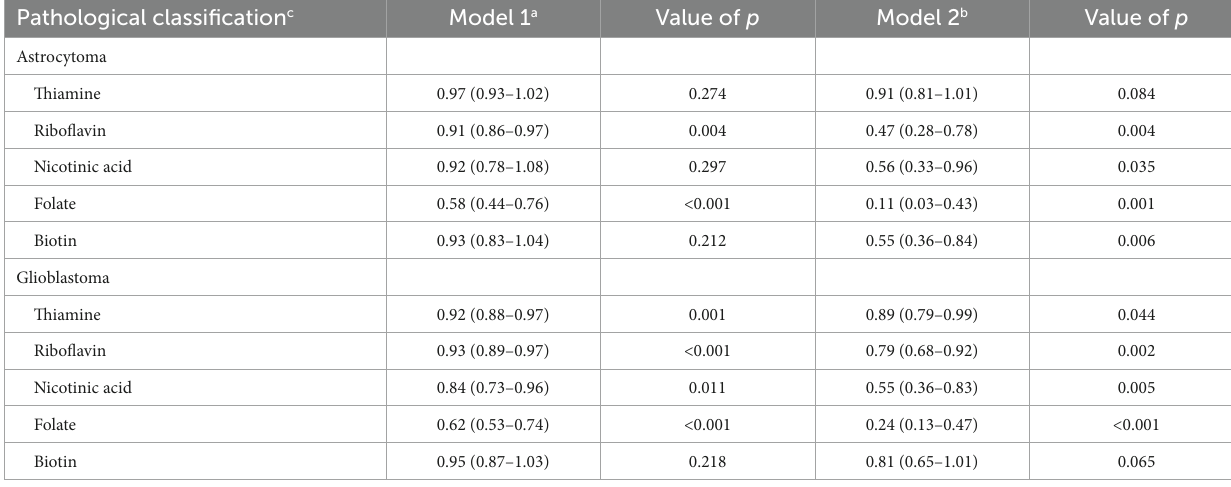
TABLE 3 Adjusted ORs and 95% CIs for the association between B vitamins and glioma of different pathological classifications. Pathological classification c